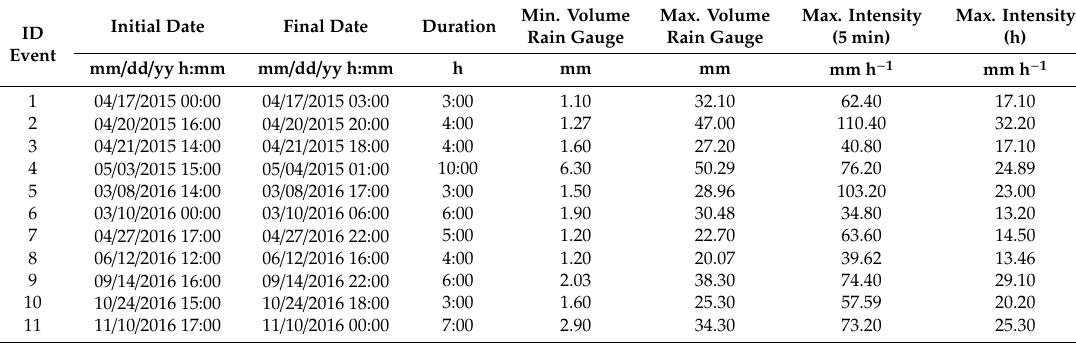
Table 2. List of 11 selected rain events that occurred between 2015 and